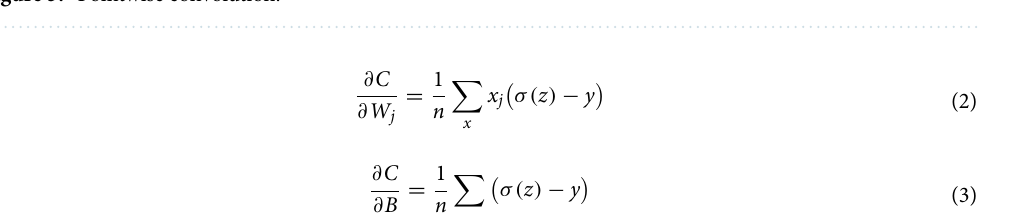
Figure 3. Pointwise